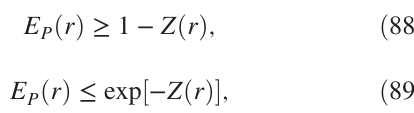
FIG. 11. Comparison of the lower and upper bounds (88) and (89) to our numerical results for the exclusion probability function E for χ ¼ 0 . 05 and χ ¼ 0 . 1 for d ¼ 3 . Here, K ¼ 1 .